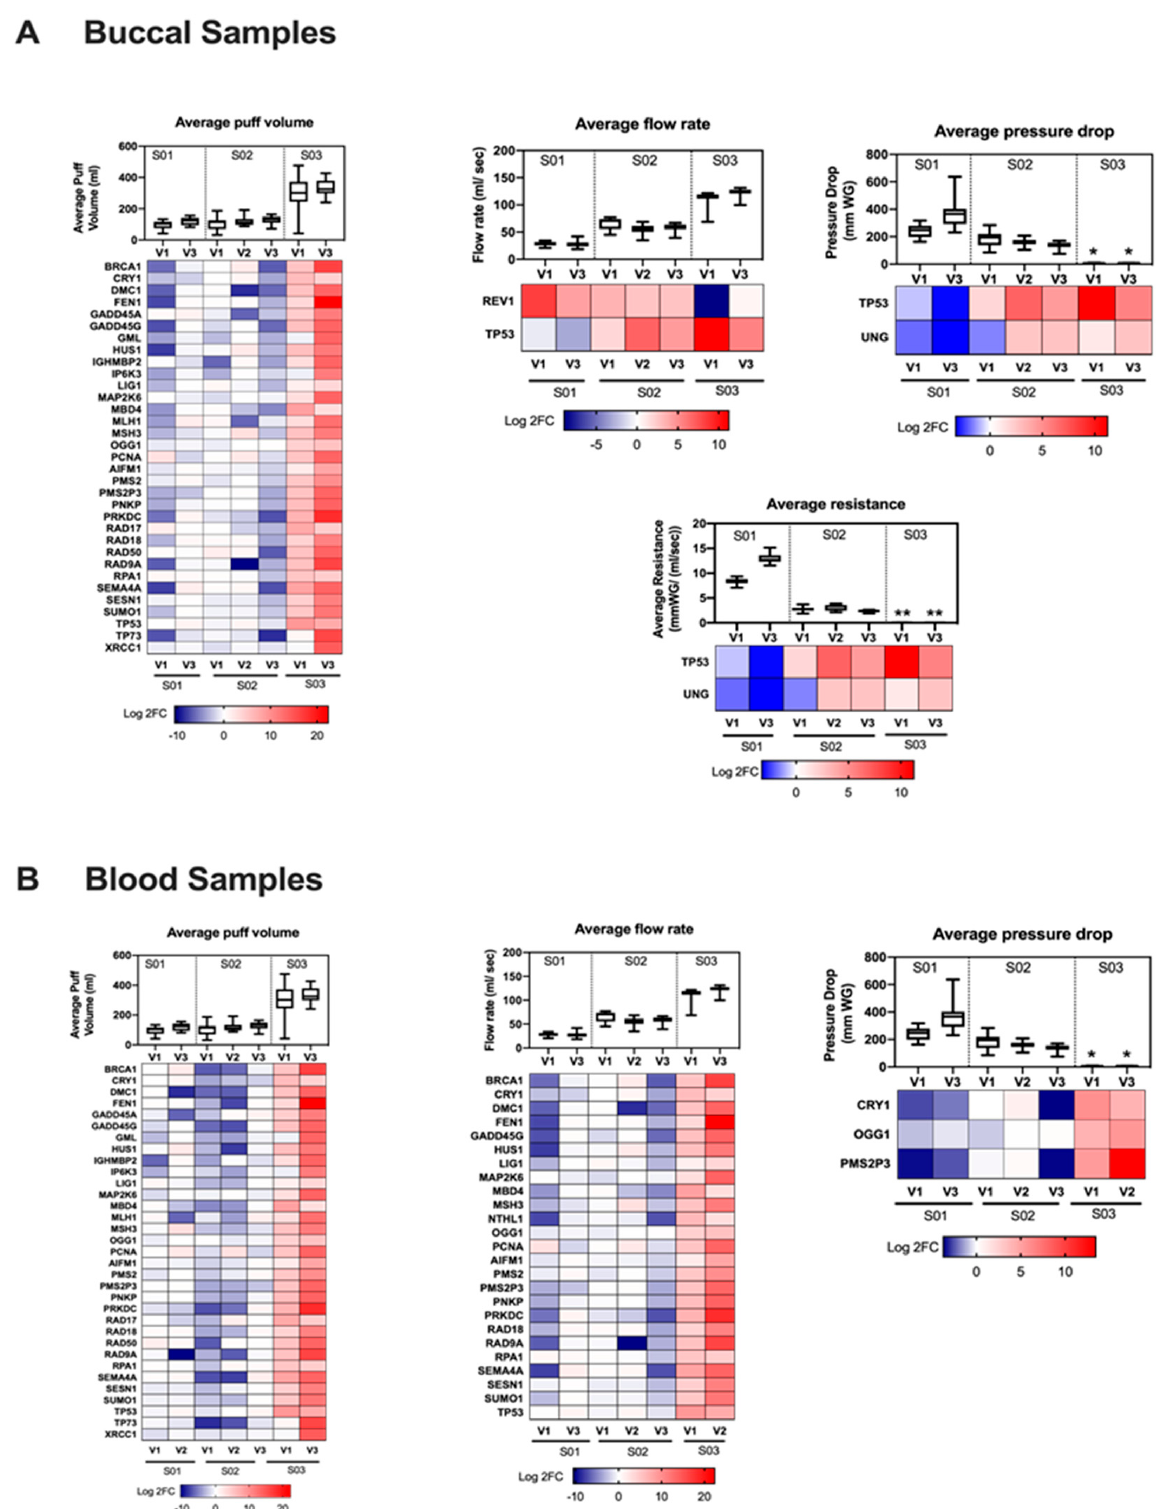
Figure 6. Genes regulated in buccal and blood samples, are vaping behaviors-dependent. Heat maps of genes that have the same trend of vaping behaviors of all subjects across the three visits in buccal ( A ) and blood ( B ) samples (n = 9) along with boxplots of clinical variables (n = 20 puffs); *: Average pressure drop of Subject 3 in visit 1 = 6.8 ± 1.5 and visit 3 = 7.3 ± 1.1 mmWG; **: Average resistance of Subject 3 in visit 1 = 0.06 ± 0.01; and visit 3 = 0.05 ± 0.008 mmWG/(mL/s). The expression of tumor suppressor TP53 is puff volume and flow rate dependent in both tissues ( A , B ).